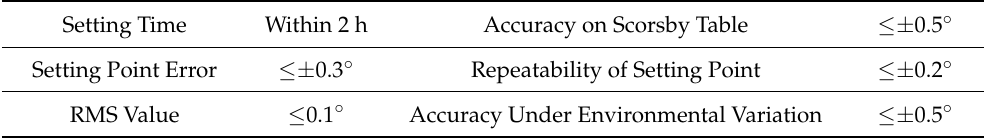
Table 3. Specifications of the TG-5000